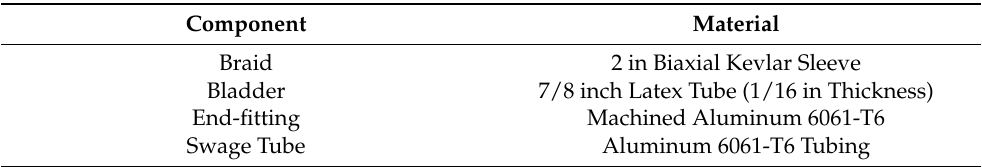
Table 1. Construction of the 22.2mm (7/8 in) diameter